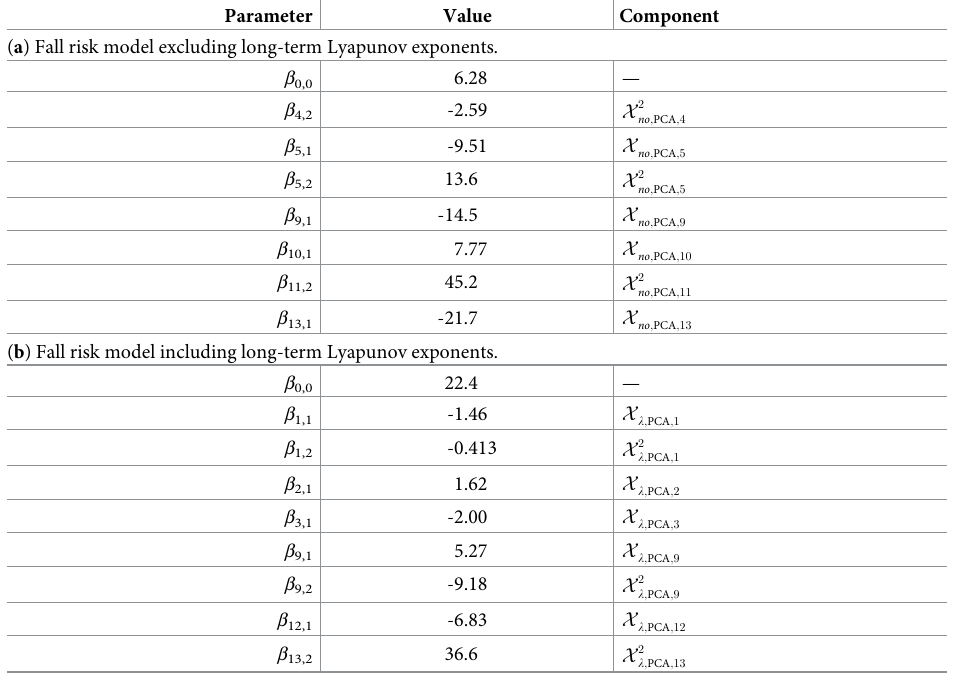
Table 6. Fall risk model parameters. Parameters not listed on these tables have a value of